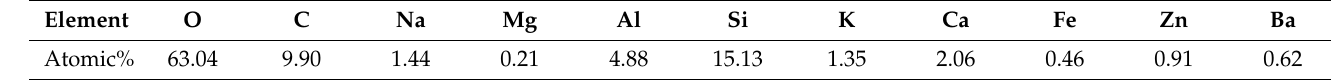
Table 8. Point 2 of EDS results of the 2-3 sample under 8000× magnification.